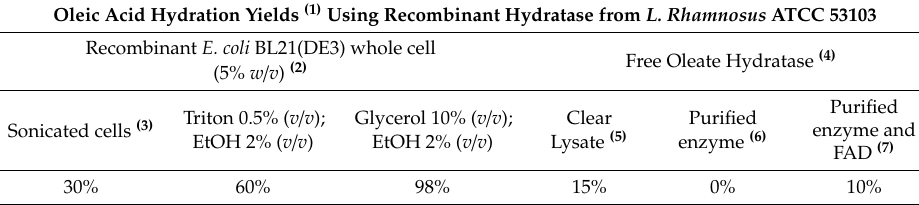
Table 1. Experimental procedure to identify the best way to use oleate hydratase (OLH). Oleic Acid Hydration Yields (1) Using Recombinant Hydratase from L. Rhamnosus ATCC